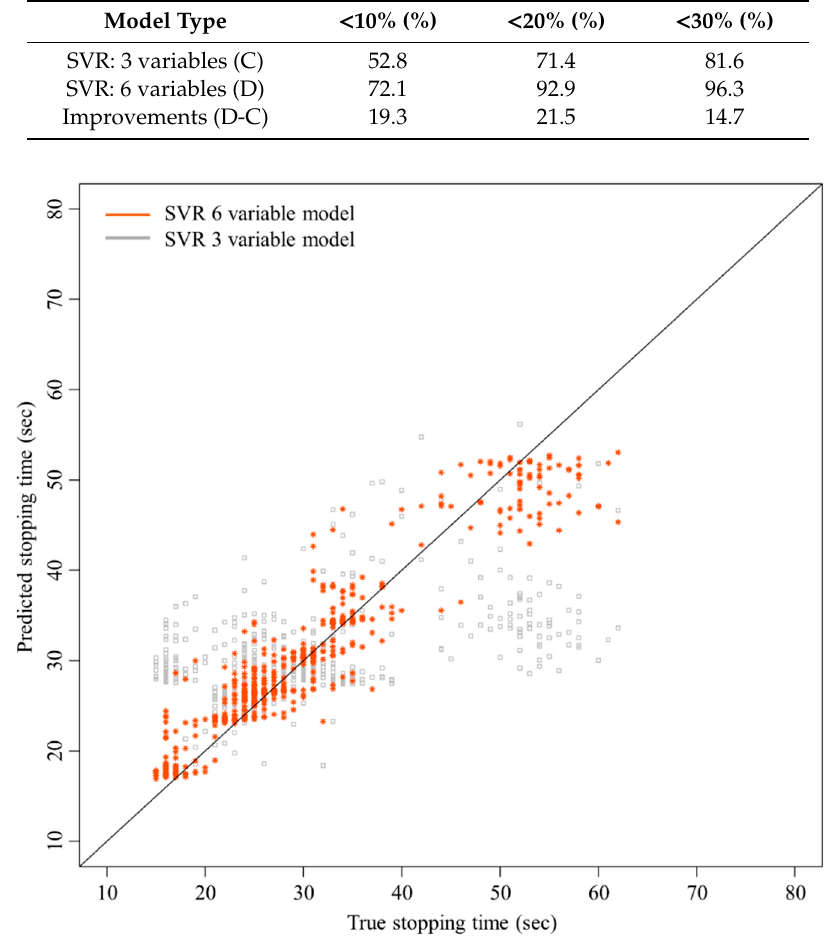
Table 5. The proportion of estimated data depends on the relative difference between actual dwell time and estimated dwell time by the number of variables of SVR models.